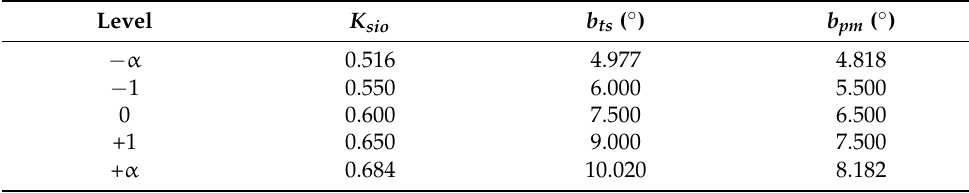
Table 4. Variables and levels of central composite